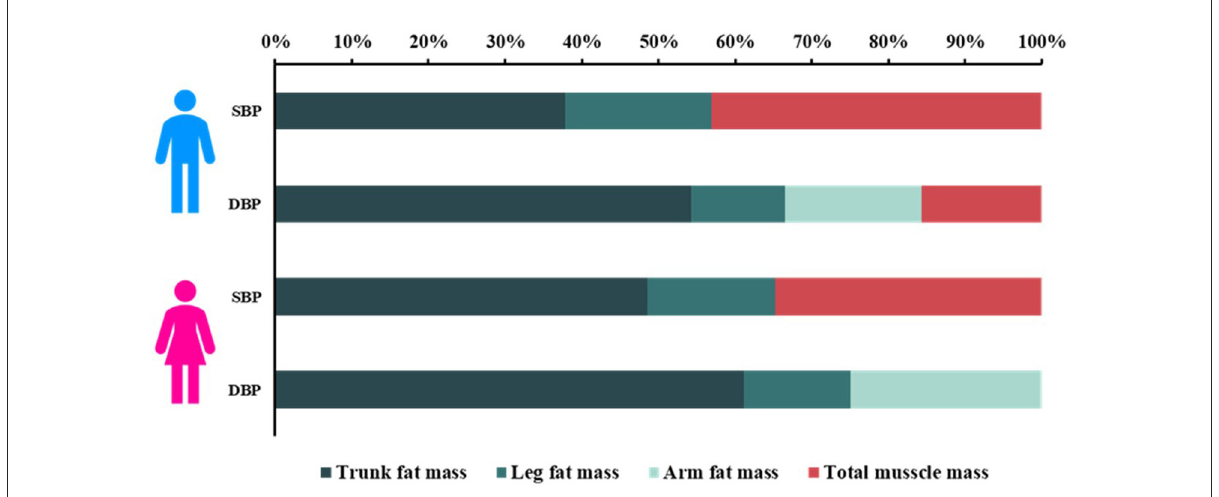
FIGURE2 Proportionate contribution of various components of body composition to BP in men and women. SBP, systolic blood pressure; DBP, diastolic blood pressure.